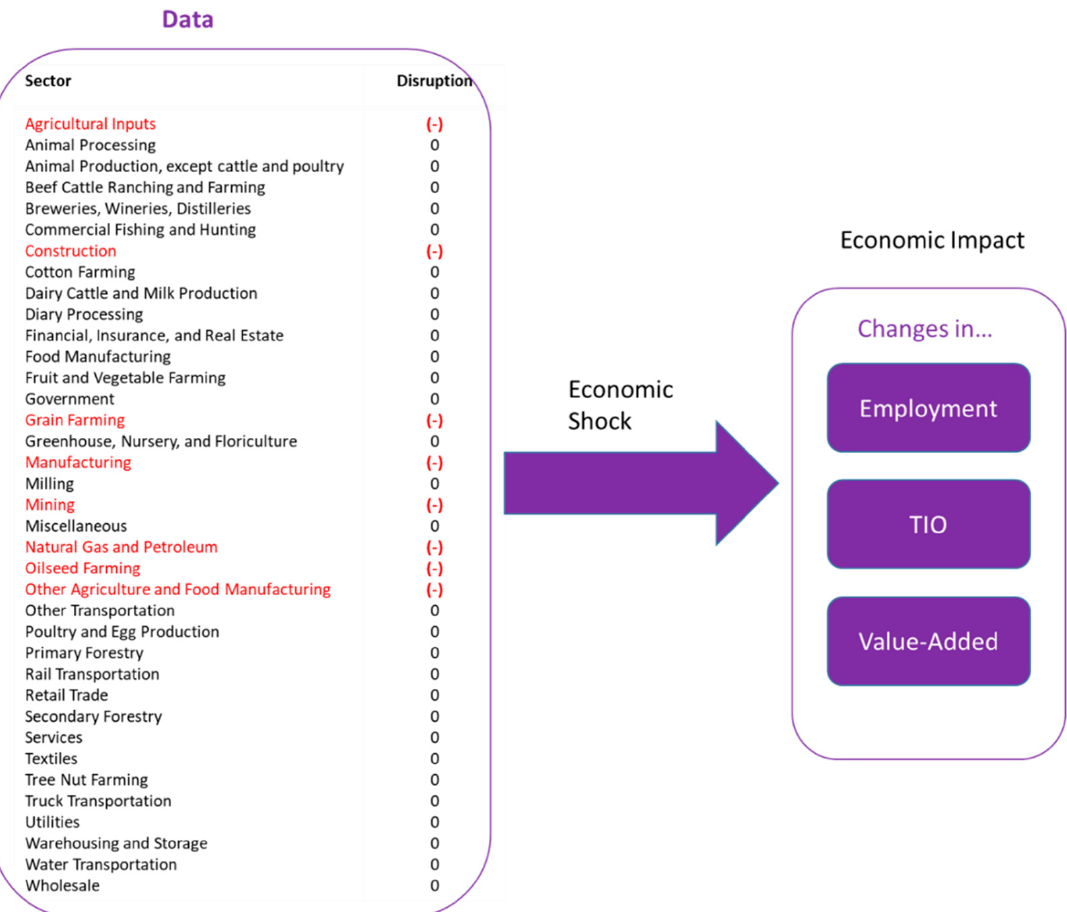
Figure 4. Scheme of economic shock and changes in employment, TIO, and value-added.